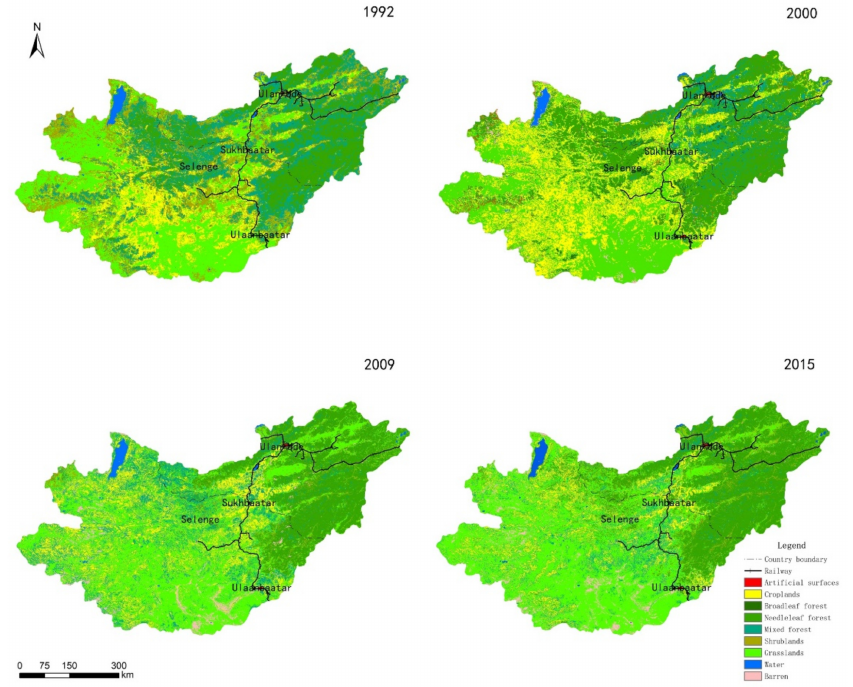
Figure 12. Land use/cover map of the Selenga River basin in 1992, 2000, 2009 and